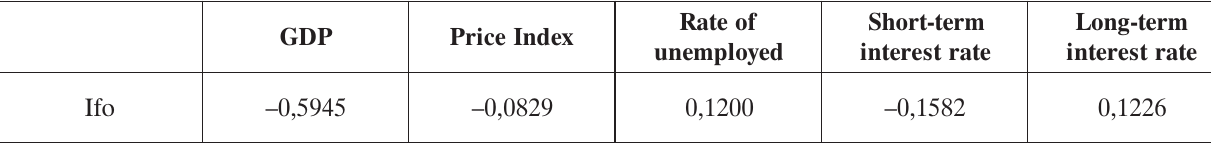
Table 4. Correlation coefficients in Germany